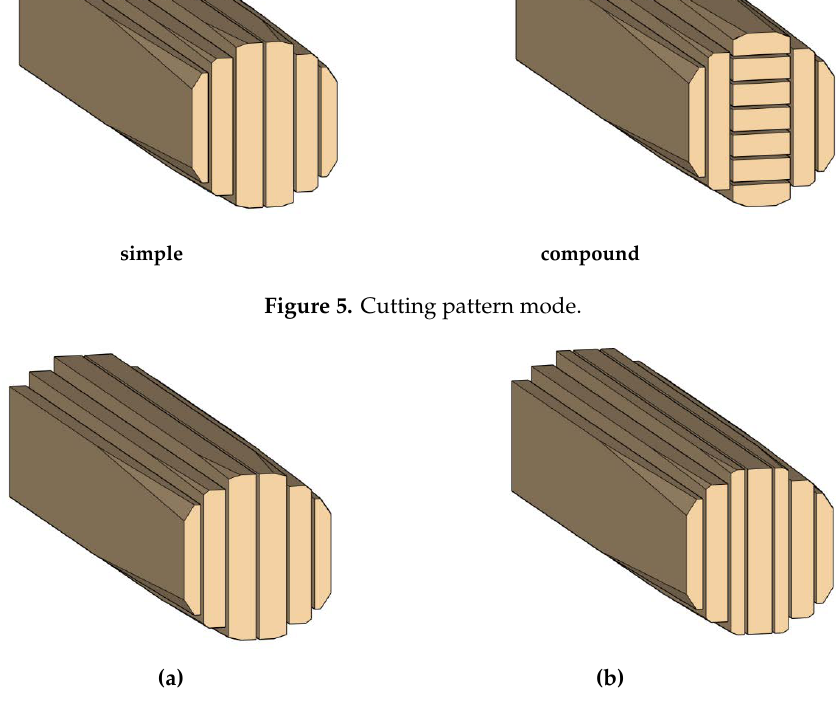
Figure 6. Layout of the cutting pattern in relation to the center of the log with the simple cutting pattern. ( a ) The cutting plane passes through the center of the log, ( b ) the center of the log is a part of the central timber.